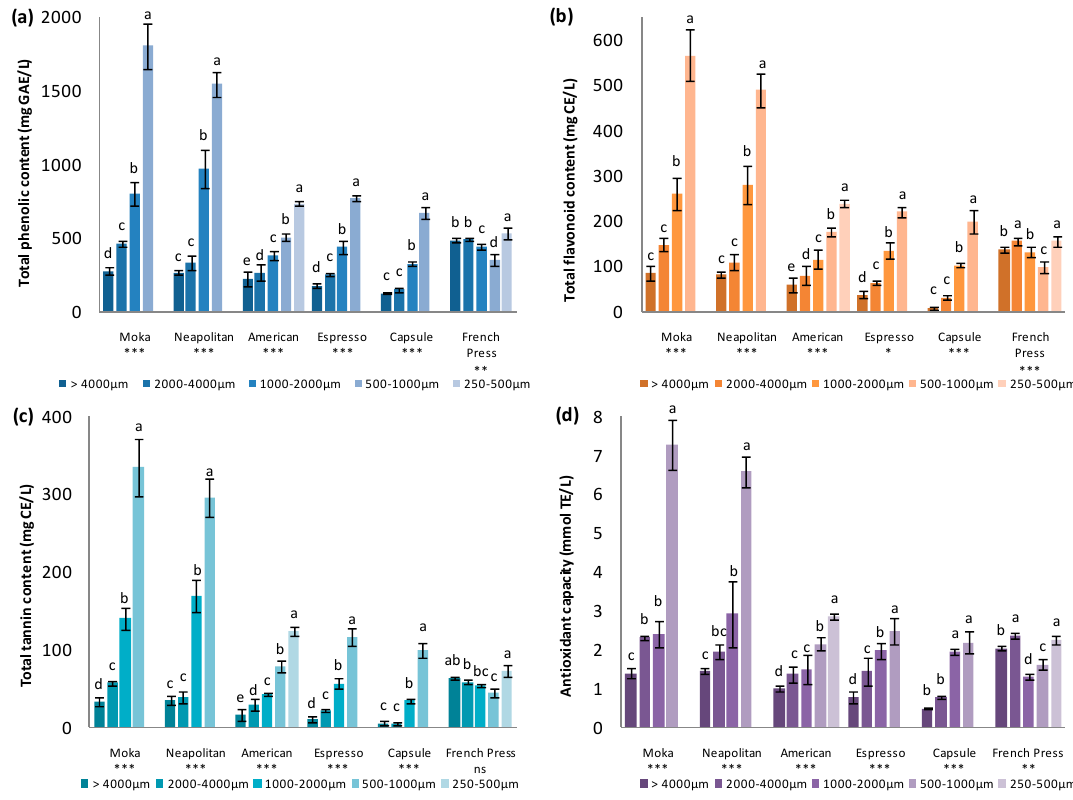
Figure 1. Total phenolic content (TPC), ( a ), total flavonoid content (TFC) ( b ), and total tannin content TTC ( c ), and antioxidant capacity ( d ) for the beverages produced by the six techniques at di ff erent CBS GDs; ANOVA among GDs for each technique. GAE = gallic acid equivalent, CE = catechin equivalent, and TE = trolox equivalent. Di ff erent letters indicate significant di ff erences at p < 0.05. Significance: * p < 0.05; ** p < 0.01; *** p < 0.001; ns = not